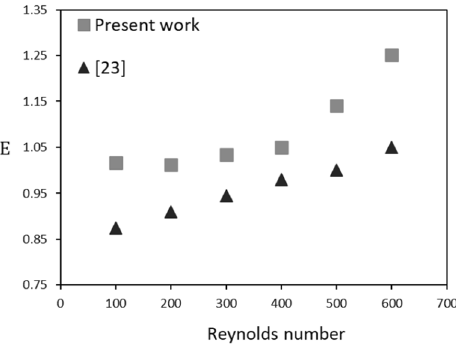
Fig. 14 Comparison of the thermal performance ratio between the present work and [23] (BR = h/H = 0.4, θ =